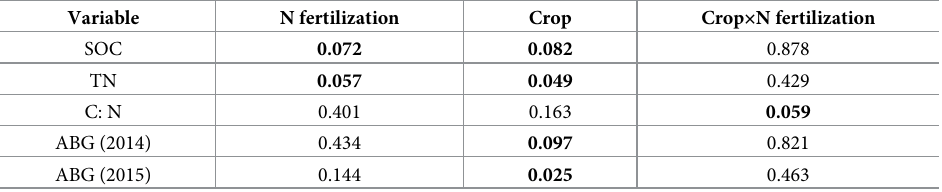
Table 1. p -values of two-way ANOVA statistical tests on the main and interactive effects of N fertilization and crop type on SOC, TN and C: N as well as aboveground plant biomass (ABG) in 2014 and 2015 under three fertili- zation treatments in SG and GG croplands at the fertilization experiment in TSU AERC in Nashville, TN, USA.